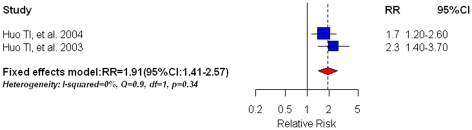
Summary estimate of relative risk (RR) for hepatic decomposition (HD) occurrence in HCC patients with pre-existing diabetes mellitus in comparison with non-diabetic patients.Squares represent study-specific estimates (size of the square reflects the study-specific statistical weight, i.e. inverse of the variance); horizontal lines represent 95% CIs; diamonds represent summary estimates with corresponding 95% CIs.